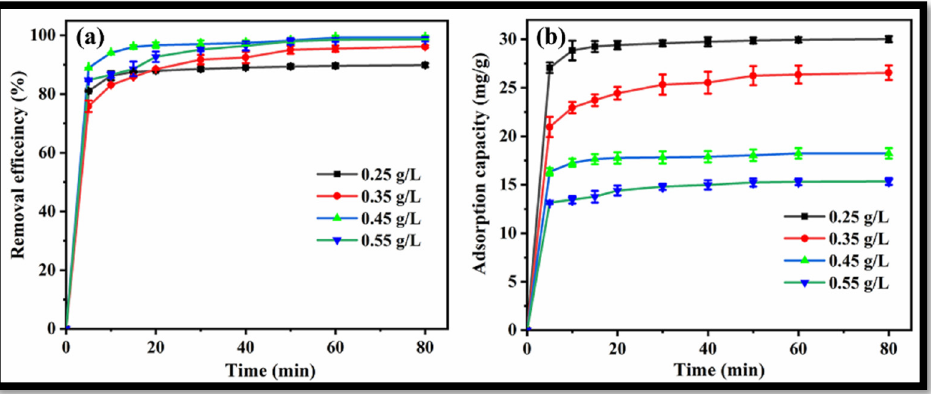
Figure 11. Effect of rGO-WO 3 heterostructure dosage on ( a ) removal efficiency and ( b ) adsorption capacity.